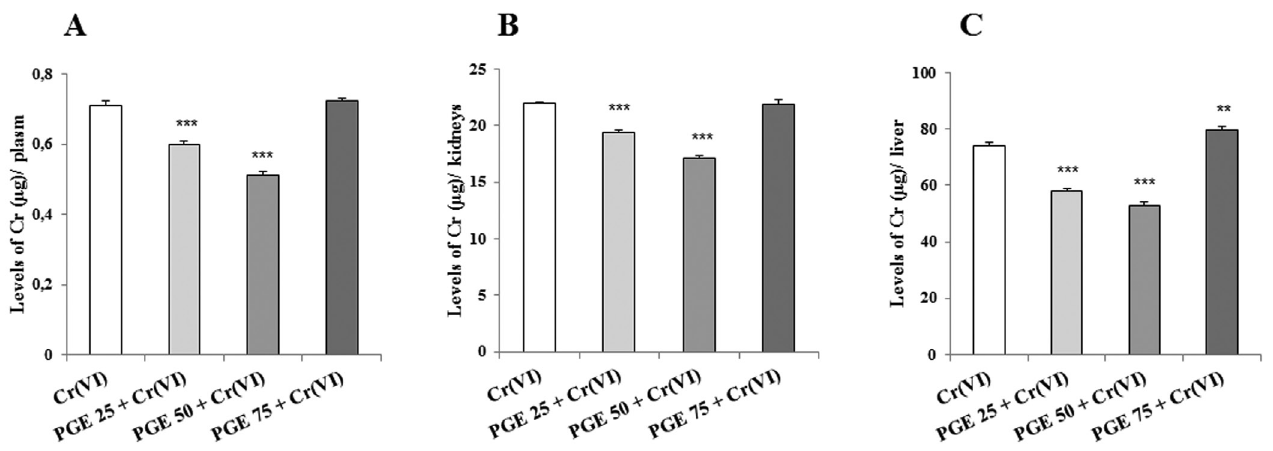
FIGURE 2 – Chromium levels present in each plasm (A), kidneys (B) and liver (C) pool of mice pretreated with PGE (25, 50 and 75 mg/kg) and exposed to a sub-lethal dose of Cr(VI) (30 mg/kg). The chromium quantification was carried out using multiple standard additions in the prepared solutions and the results were expressed in the amount of Cr present in each organ or plasm pool. Each bar presents mean±SD of three replicate analyses for each sample. (**p<0.01 and ***p<0.001 vs. Cr(VI). One